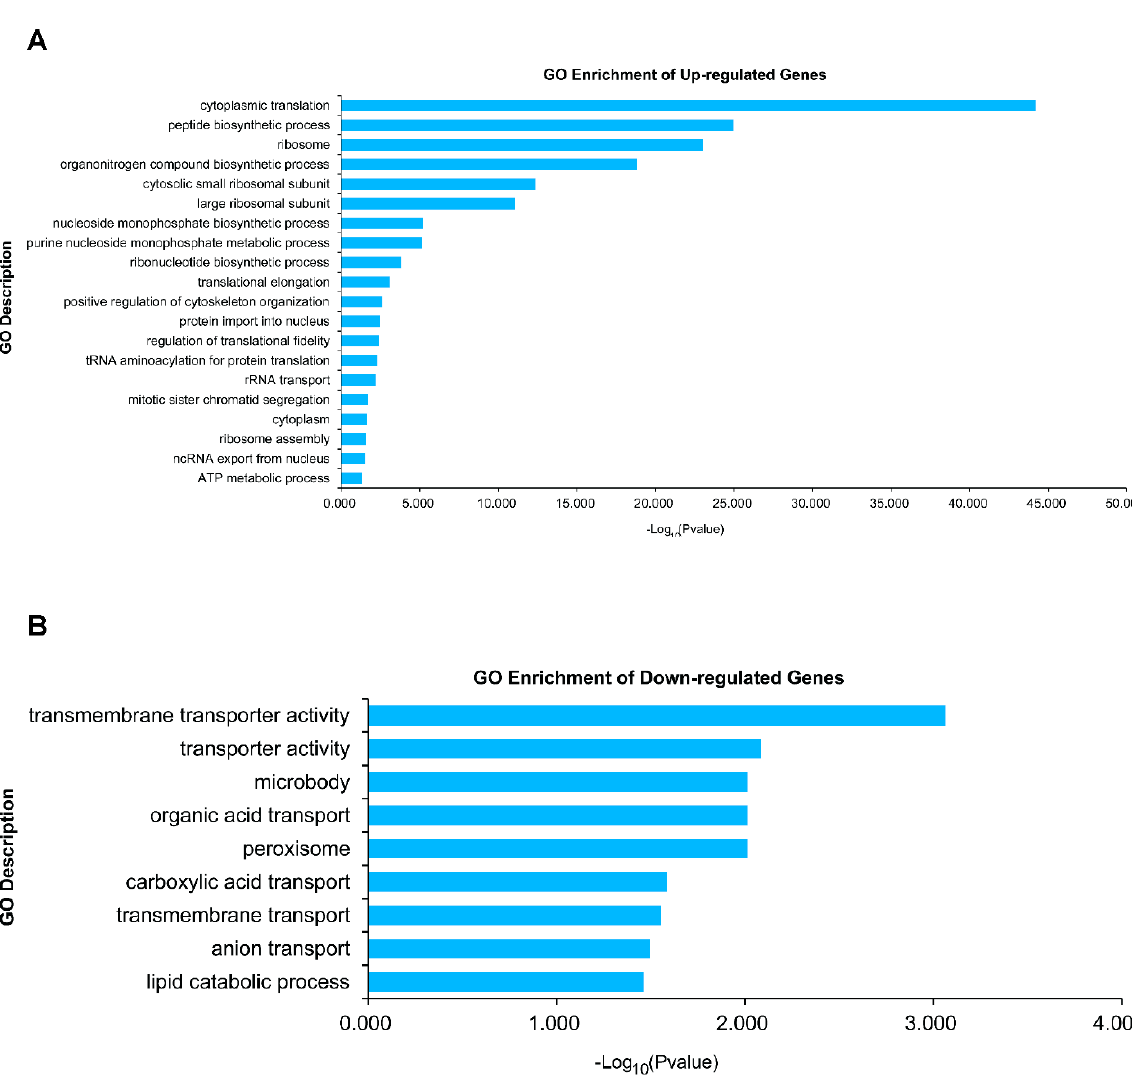
Figure 13. Molecular functions of the genes up-regulated ( A ) and down regulated ( B ) in Δ Mogln2 at a two-fold expression threshold based on the Gene Ontology (GO) terms.